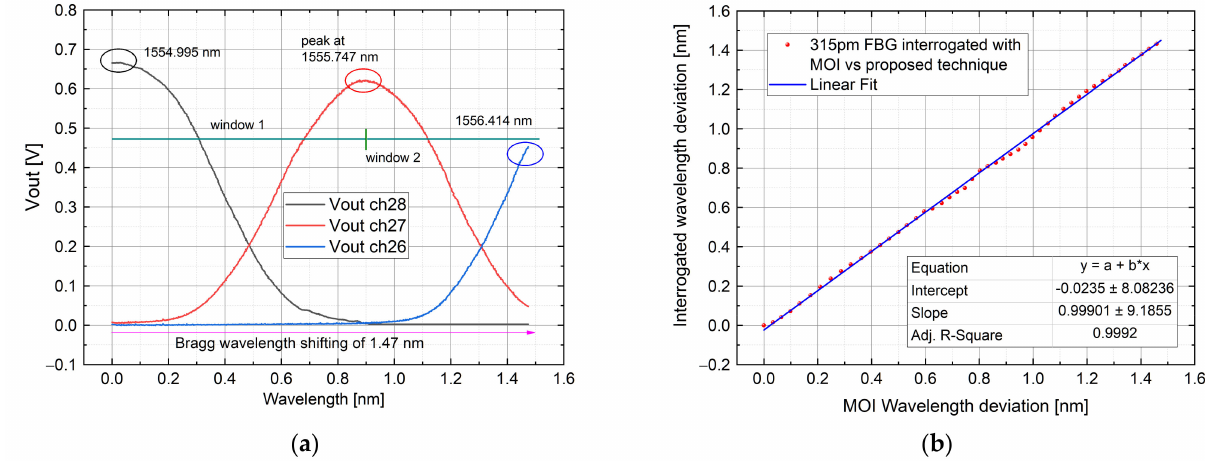
Figure 9. Interrogation of a 315 pm bandwidth FBG among AWG channel 28, 27 and 26: Channel output voltage ( a ); interrogated wavelength with a commercial system vs. proposed one compared with a linear fit in a dynamic range of measurement close to 1.5 nm ( b ). Here, the starting Bragg wavelength position is at the Ch 28